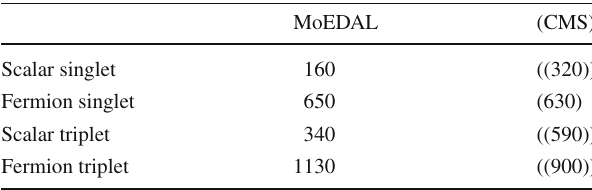
Table 2 Compilation of the prospective MoEDAL mass reaches (